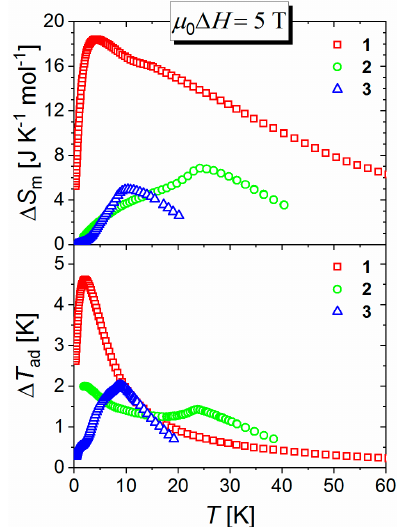
Figure 19. Temperature dependences of the isothermal entropy change ∆ S m and the adiabatic temperature change ∆ T ad corresponding to the applied field change of µ 0 ∆ H = 5 T for the three studied compounds.